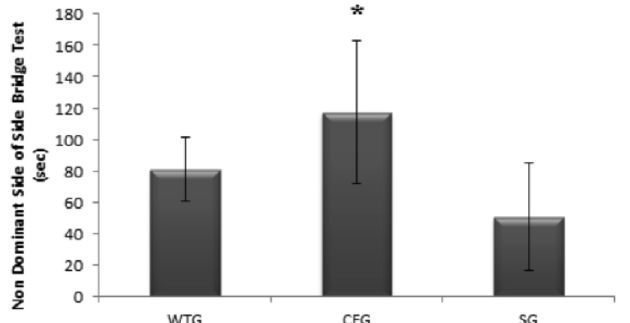
Figure 2. Mean and standard deviation of the side bridge test endurance time regarding the non-dominant side.